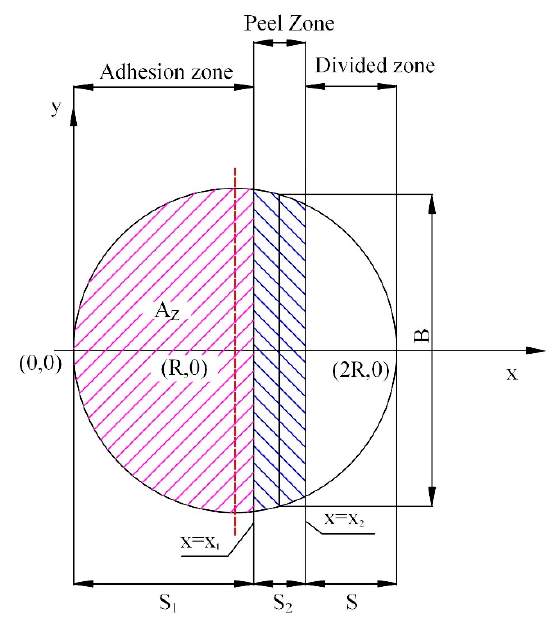
Figure 8. Zones definitions in the second stage of the barnacle scraping.